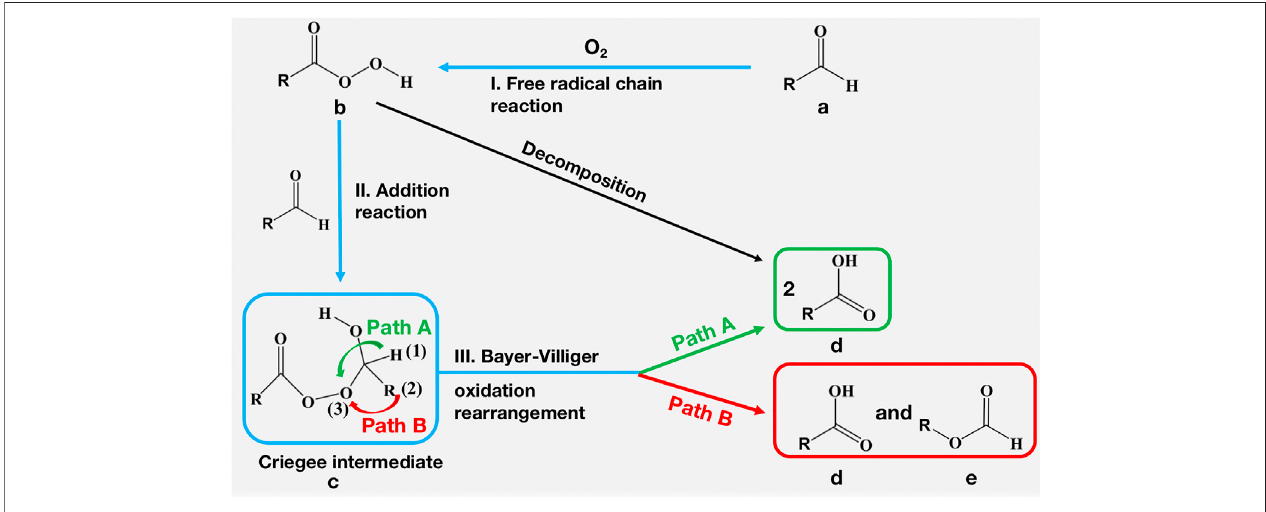
SCHEME 1 | The mechanism of autoxidation reaction of aldehyde compounds.